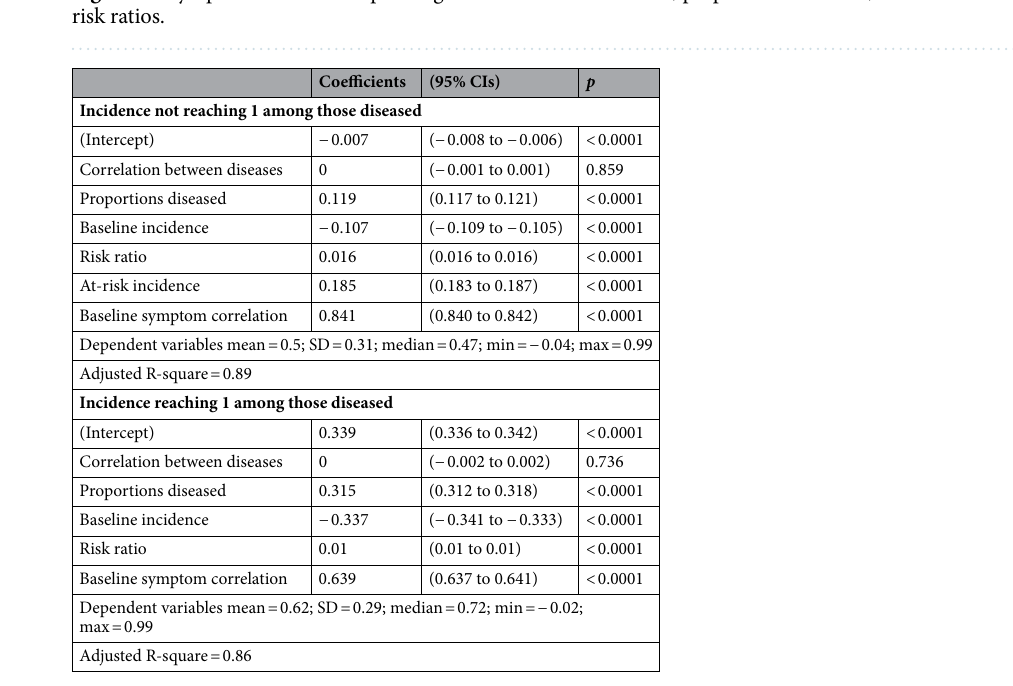
Table 4. Effects of baseline incidence, proportions diseased, risk ratios, and baseline symptom correlations on overall symptom correlations. CI confidence interval, SD standard